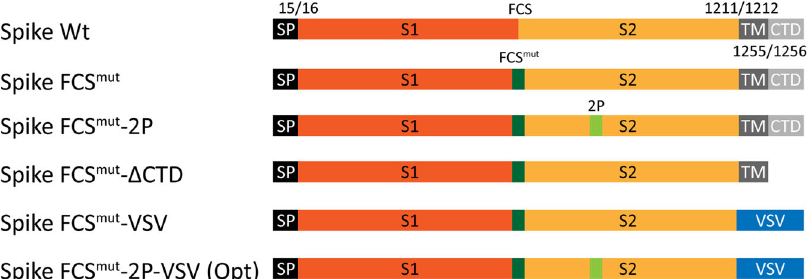
Fig. 1 Schematic representation of the SARS-CoV-2 S antigen designs. The position of the wild-type signal peptide (SP), the S1 and S2 subunit, the furin cleavage site (FCS), the transmembrane (TM), and cytoplasmic tail domain (CTD) are indicated. Constructs contain various alterations including FCS mutations (FCS mut : R 682 A/R 683 A), proline stabilizing mutations (2P: K 986 P/V 987 P), deletion of the CTD, and replacement of the TM/CTD by that of the vesicular stomatitis virus G protein